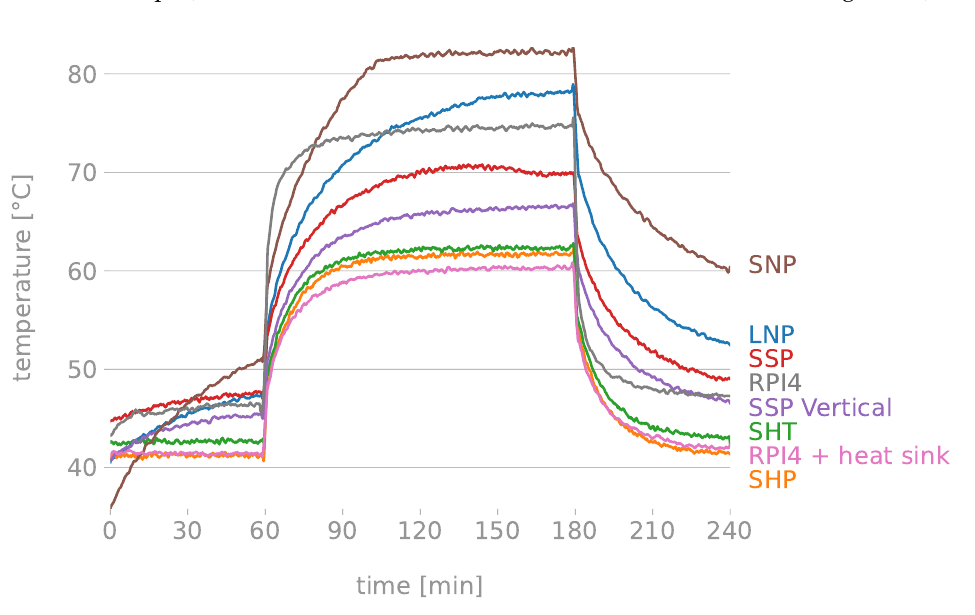
Figure 2. Temperature responses in time of the RPi using different setups (heat sink and enclosure) when performing a stress